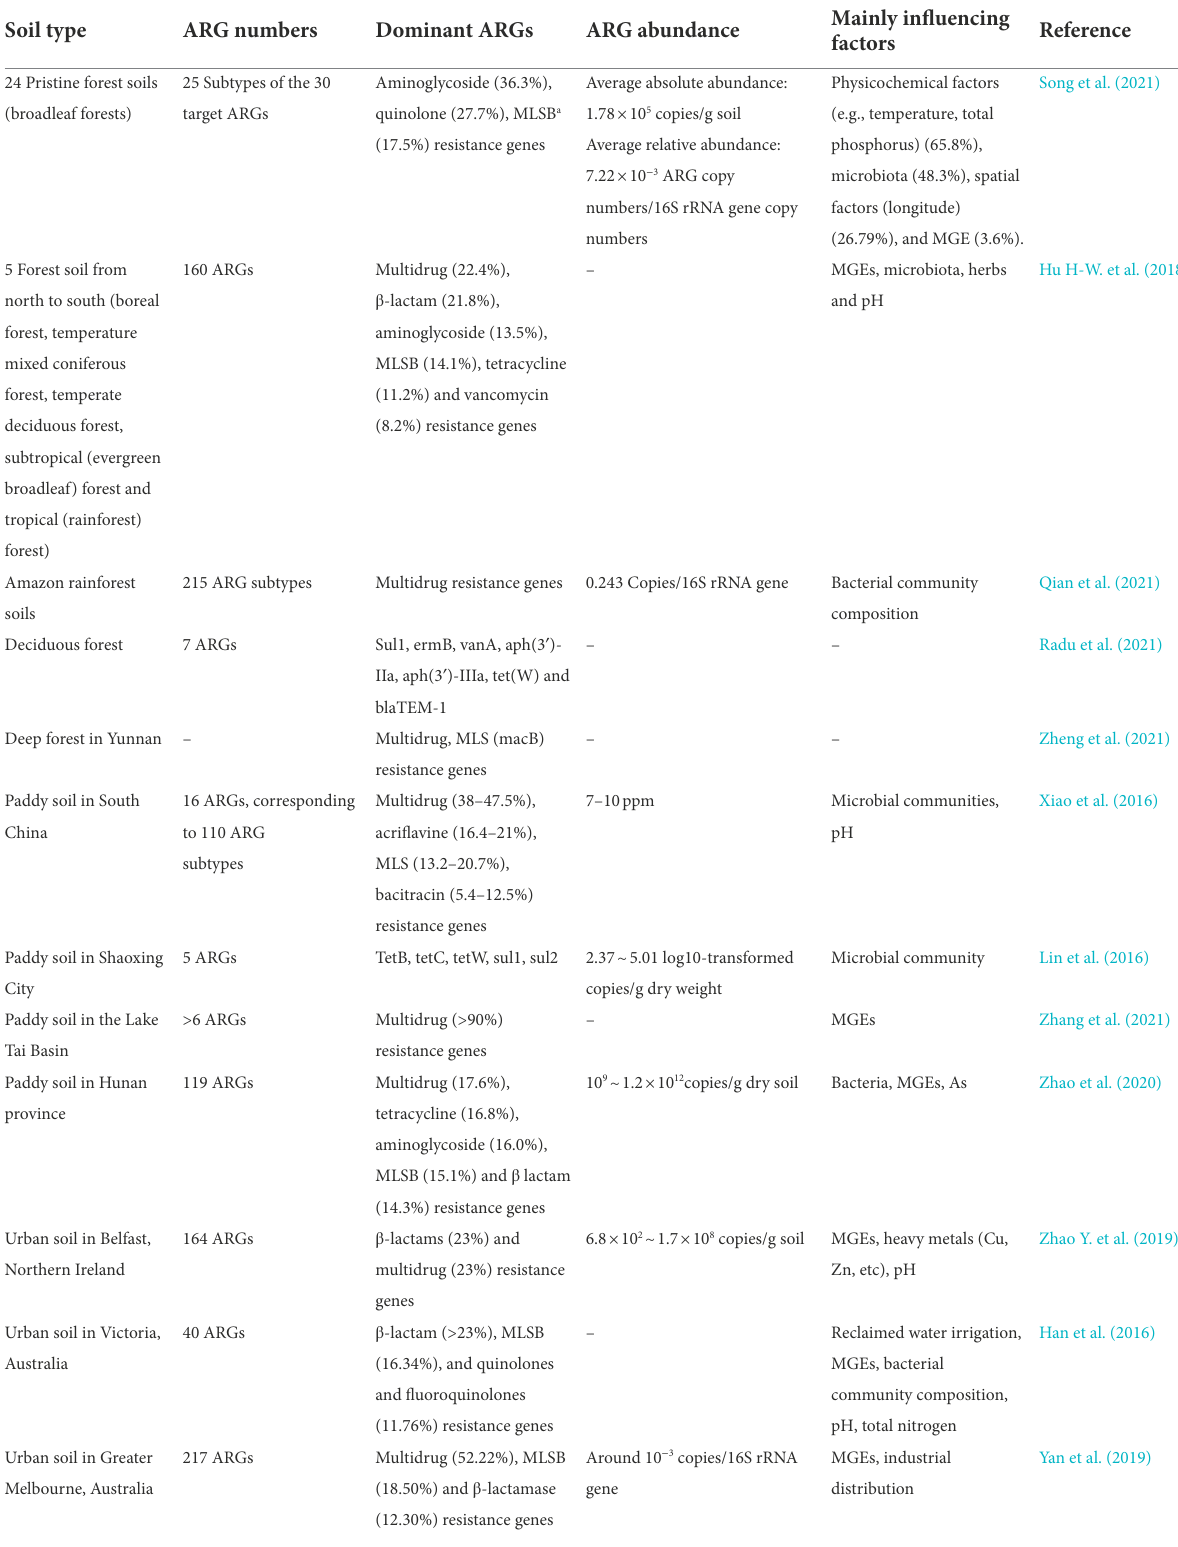
TABLE 1 Antibiotic resistance genes (ARGs) and mainly influencing factors in different soil